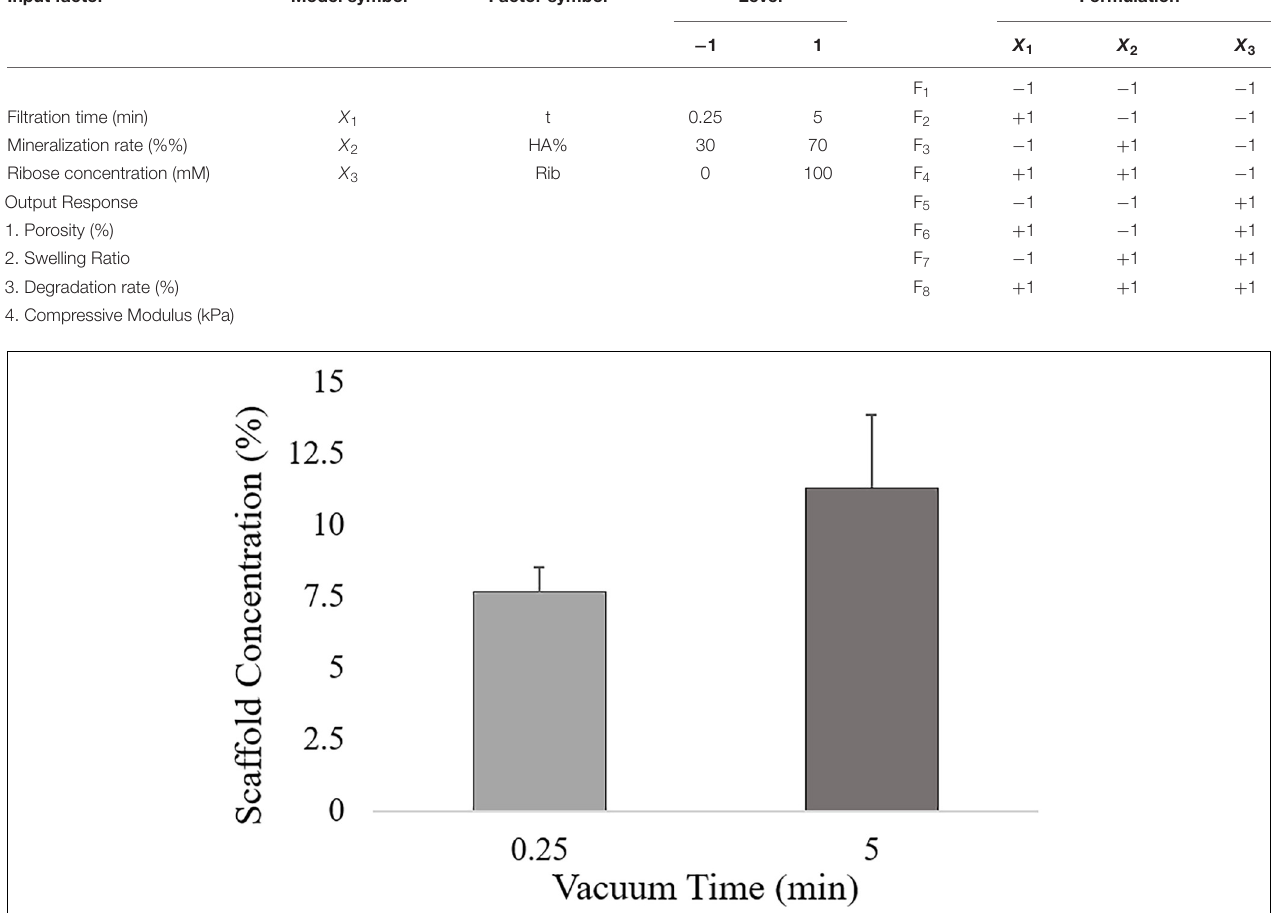
FIGURE 1 | Hydrogel concentration for low (0.25 min) and high (5 min) vacuum time levels, calculated as the ratio between the scaffold weight after freeze-drying and the HA/Collagen wet